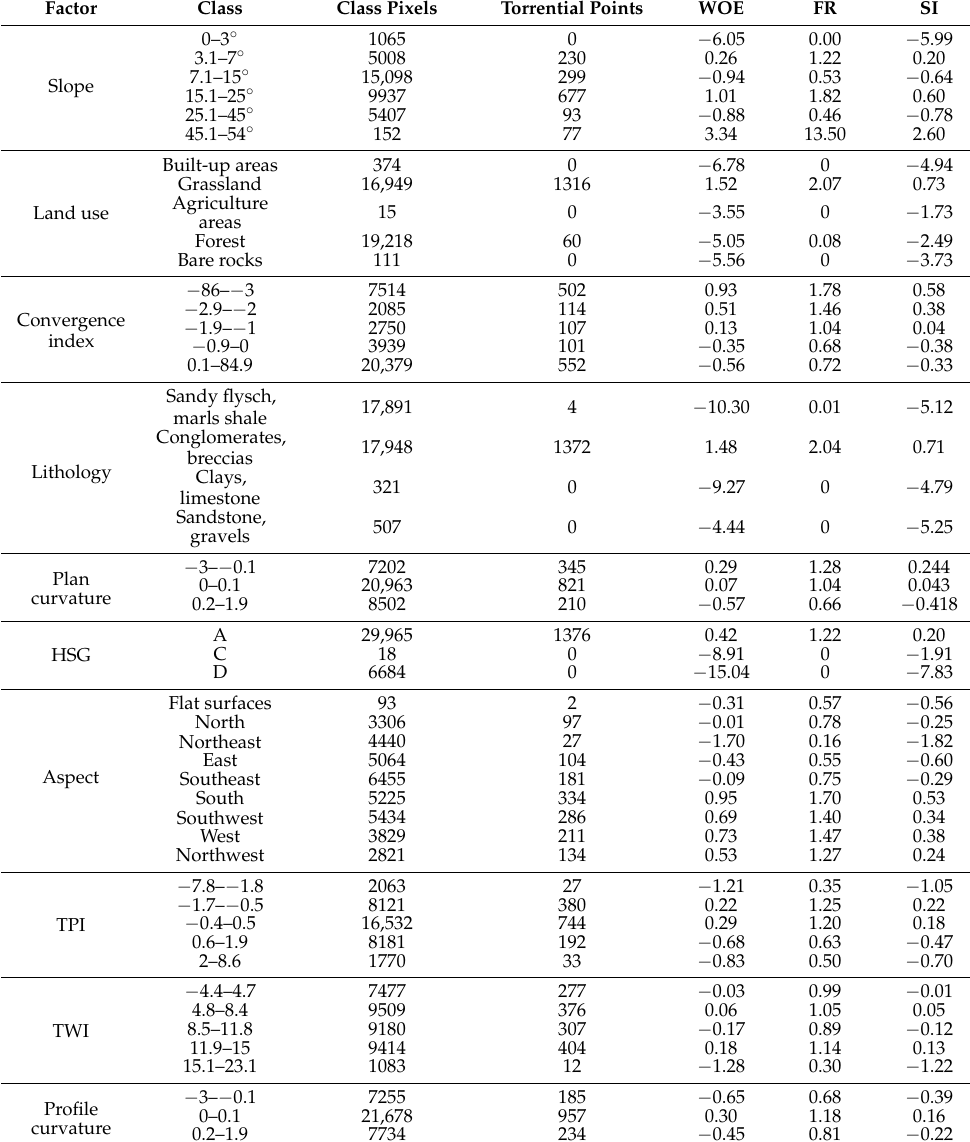
Table 1. Bivariate statistics of flash-floods conditioning factors classes. Factor